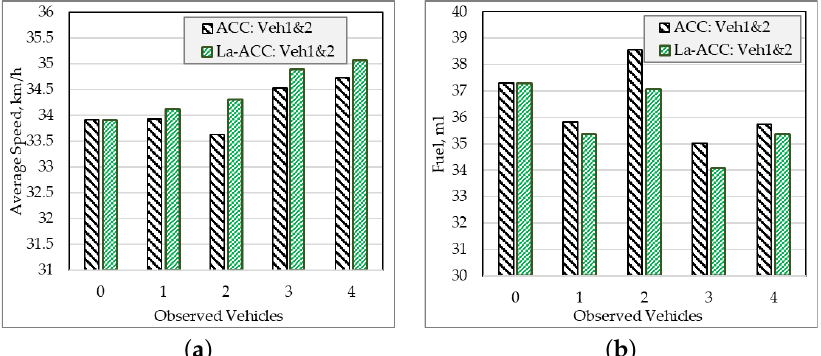
Figure 7. Individual performance when vehicles 1 and 2 are controlled by ACC or La-ACC: ( a ) average speed; ( b ) fuel